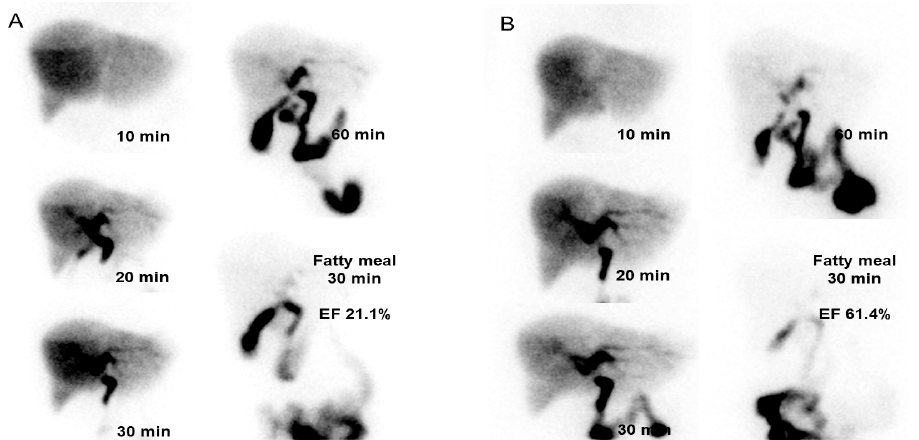
Figure 3. Boxplots for the GBEFs at the initial and follow-up measurements. The mean GBEFs at the initial and follow-up measurements were 42.6% (range, 6.5–68.2%) and 53.0% (range, 16.6–79.6%), respectively. The 10.4% change in GBEF was significant ( p = 0.012). GBEF, gallbladder ejection fraction.